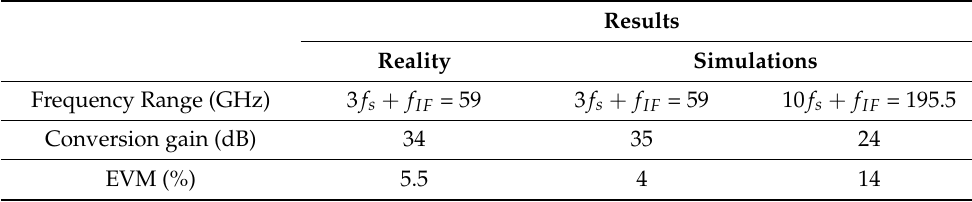
Table 1. The comparison between the real and simulated work depended on the differential modu- lation SOA – MZI by the electro optical sampling.